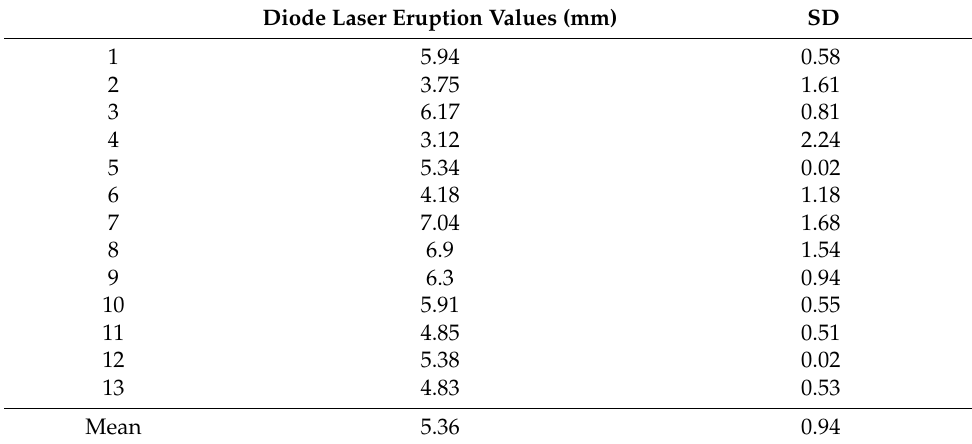
Table 1. Measurement of eruption and standard deviation of the 13 canines monitored at 16 weeks after the laser